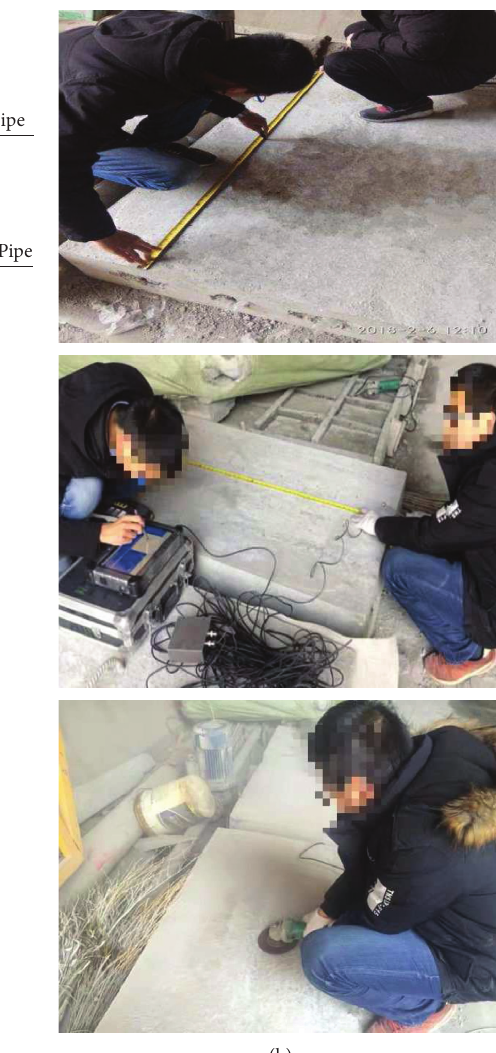
Figure 5: Schematic diagram of specimen 1. (a) Specimen size drawing. (b) On-site test piece